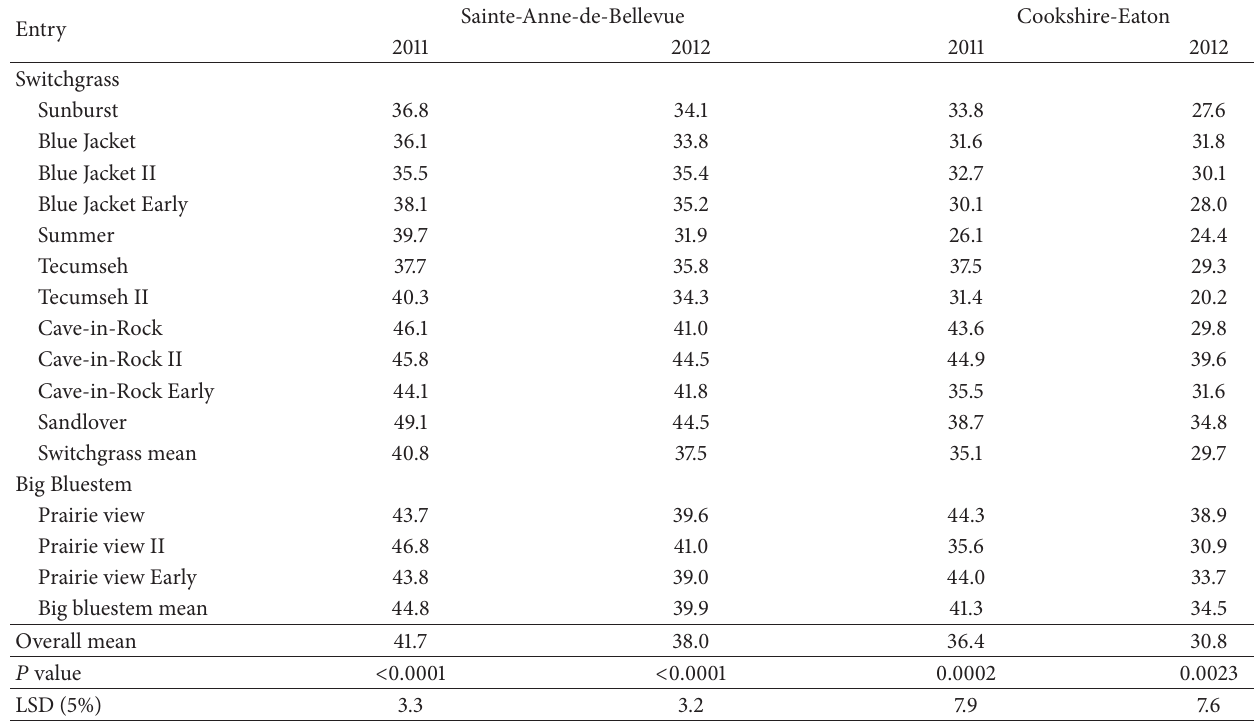
Table 3: Moisture concentration (%) at fall harvest of 11 selections of switchgrass and 3 selections of big bluestem at two sites in Southern